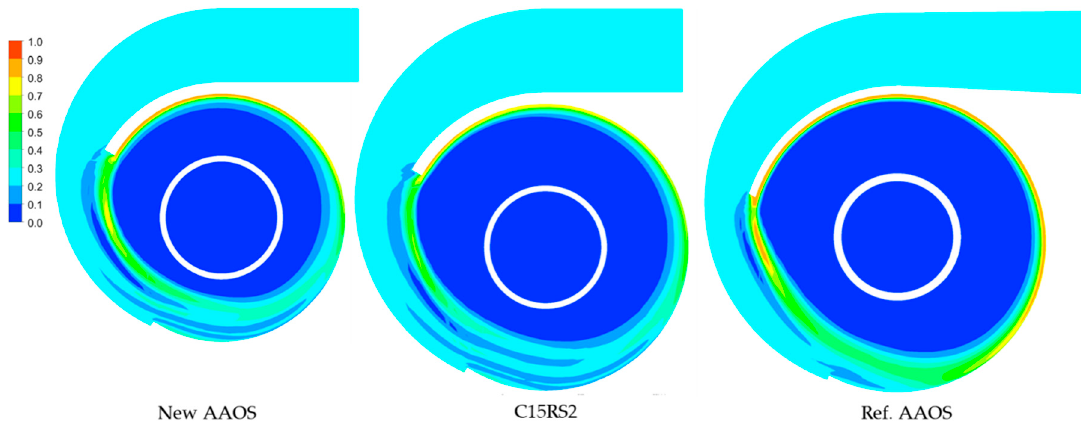
Figure 12. Average oil fraction contours—plane 1 − 1.